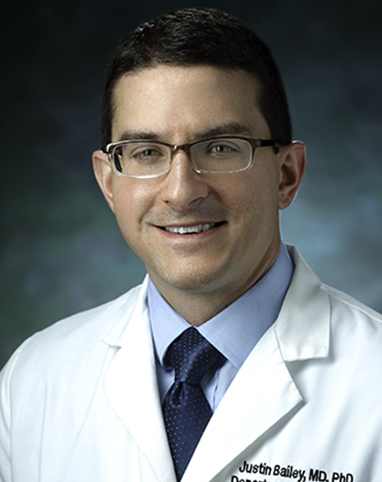
Justin R. Bailey